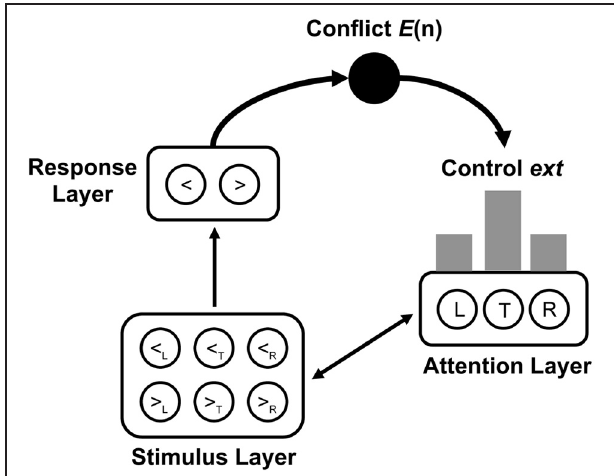
FIGURE 1 | Architecture of the conflict adaptation model by Botvinick et al. (2001). The stimulus layer contains one unit for each combination of arrow type ( < = left arrow, > = right arrow) and stimulus position ( L = left flanker, T = target, R = right flanker). The response layer contains one unit for each response ( < = left response, > = right response). The attention layer contains one unit for each stimulus position. Conflict E ( n ) , resulting as a function of activity in the response layer, is used to adjust the control parameter ext, which determines activity in the attention unit. Gray bars indicate the average distribution of activity across stimulus positions in the attention